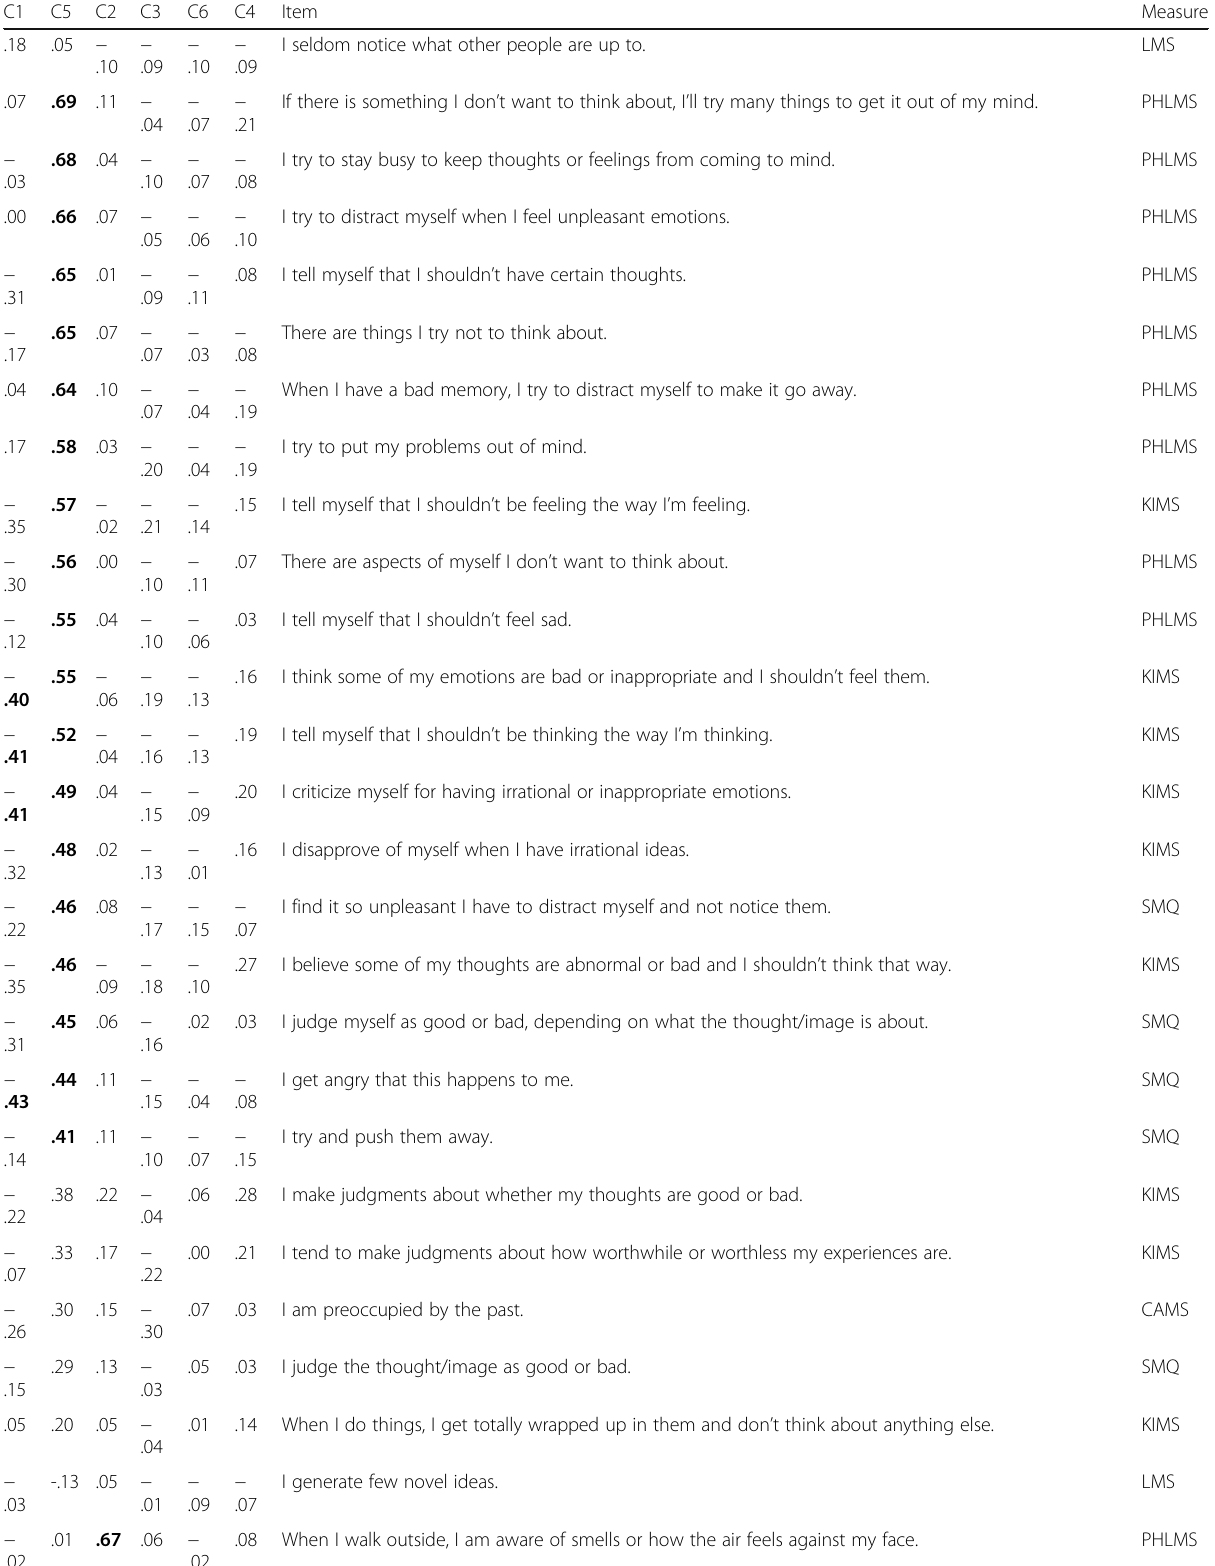
Table 4 Component loadings of the mindfulness items on the final six components